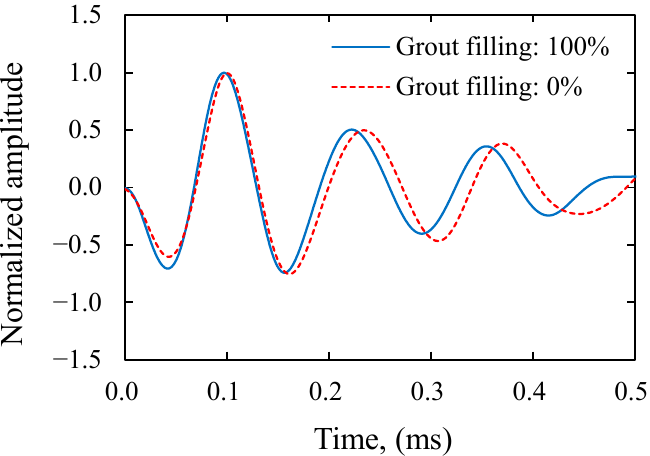
Figure 12. Example of response waveform after normalization (Case_1: φ s = 63 mm).